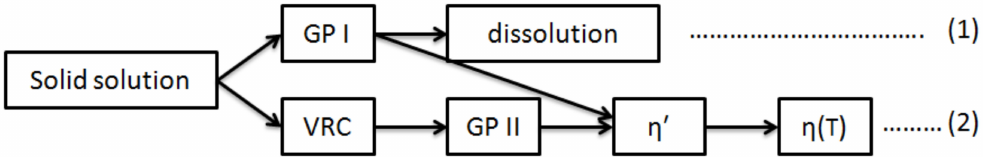
Figure 5. The aging precipitation sequence of 7xxx aluminum alloys.